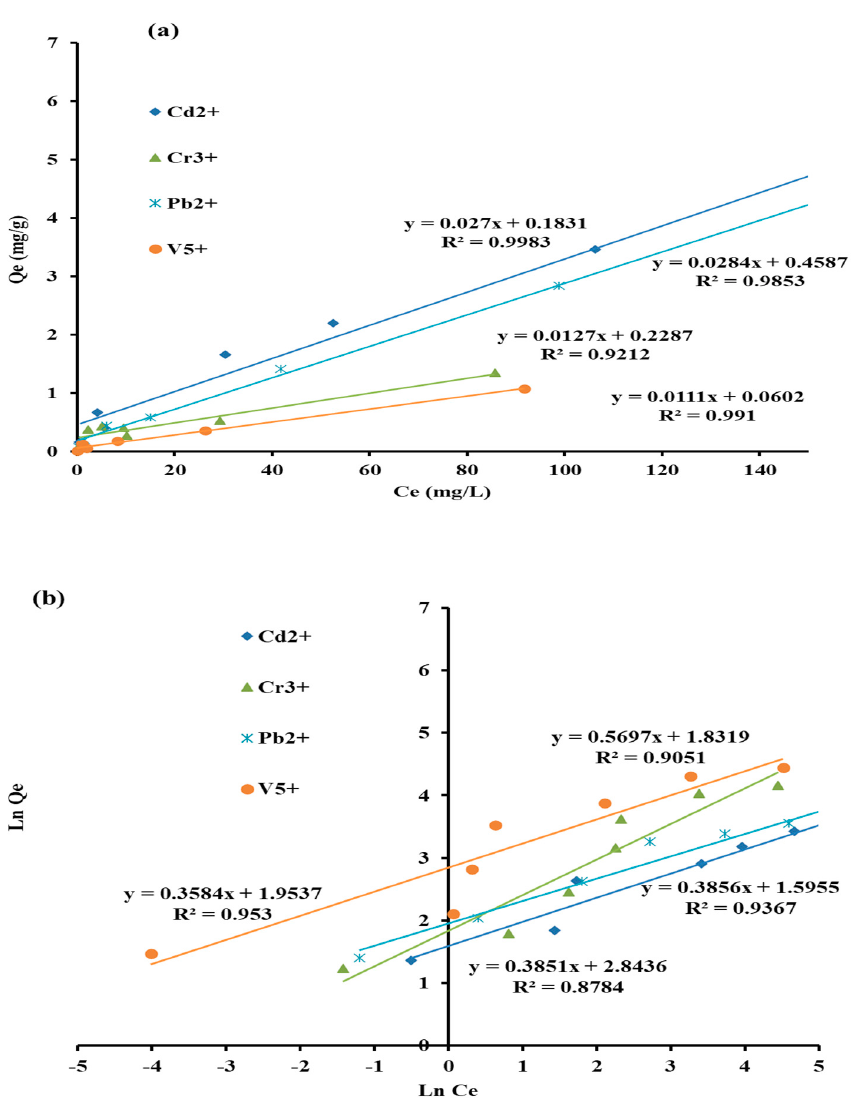
Figure 10. Adsorption isotherm models of Langmuir ( a ) and Freundlich ( b ).